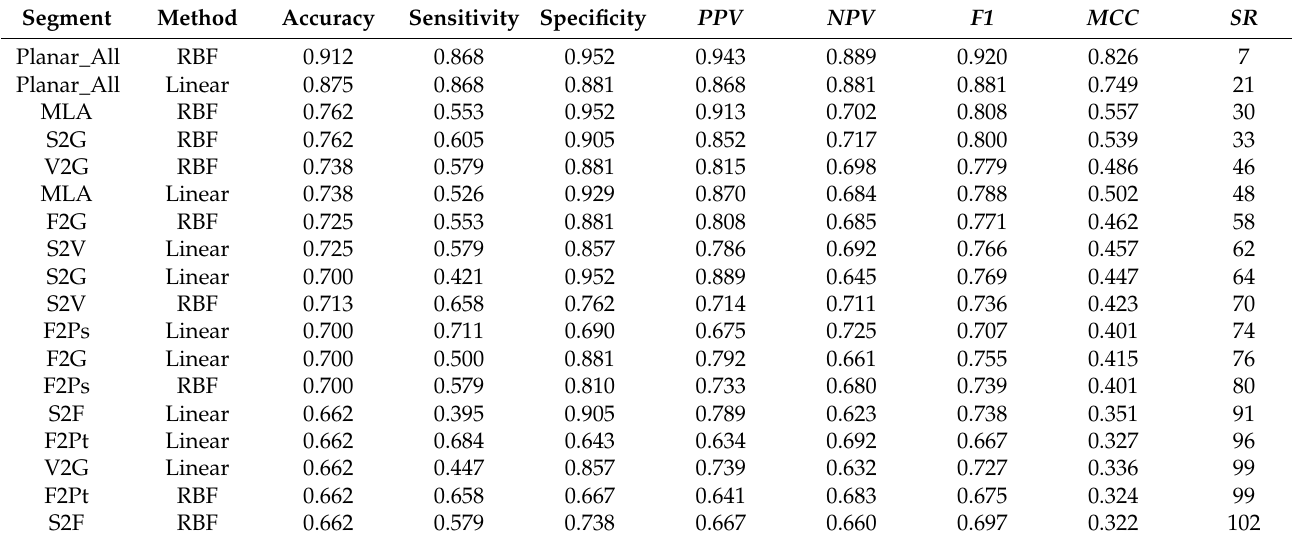
Table 4. Classification models based on planar